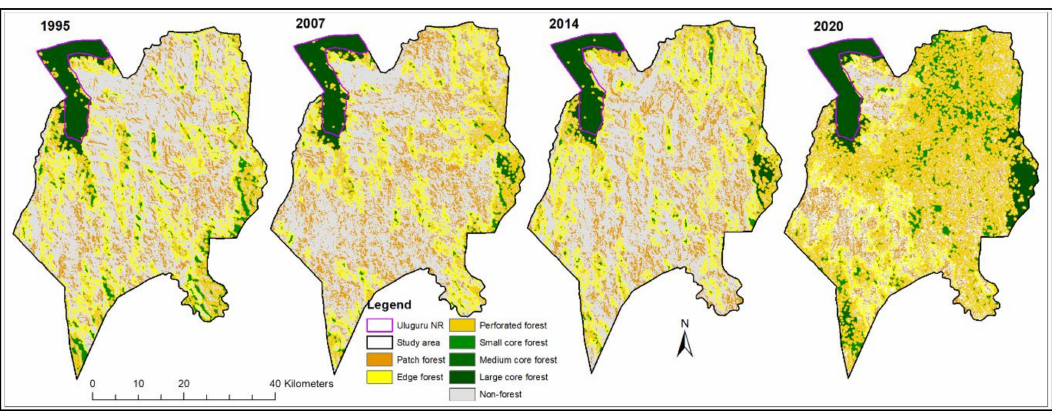
Figure 3. Maps of the forest fragmentation pattern in the study area for the years 1995, 2007, 2014, and 2020. Table 7. Forest fragmentation and annual change of each class (% area), 1995–2020. Forest Cover (%) Forest Cover Change (%) Forest Class